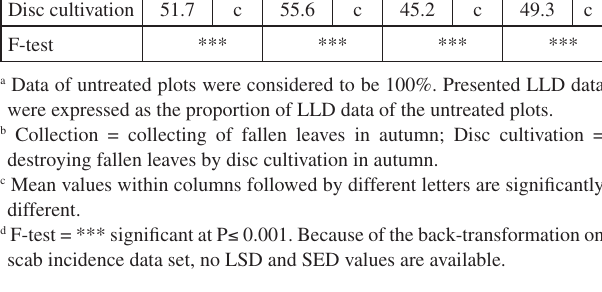
Table 3. Scab incidence (%) in spring in three sanitation treatments at farm-scale level on cv. Jonathan and on cv. Prima at Eperjeske in